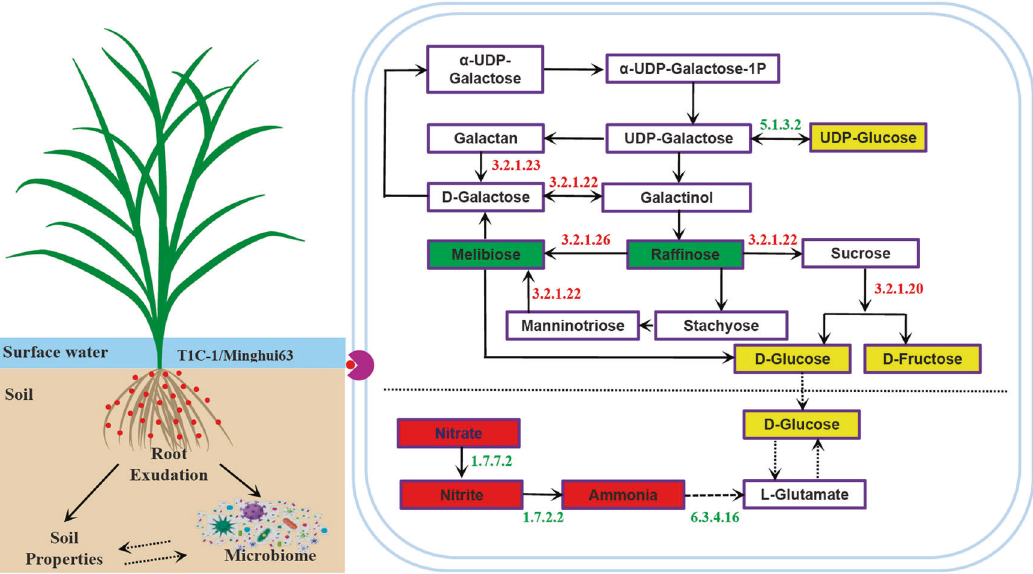
Fig. 8 Variation in carbon and nitrogen metabolism due to cultivation of Bt rice. Different N forms, metabolites, and enzymes in T1C-1 soils that were signi fi cantly increased or depleted compared to Minghui 63 soils are annotated in red or green,